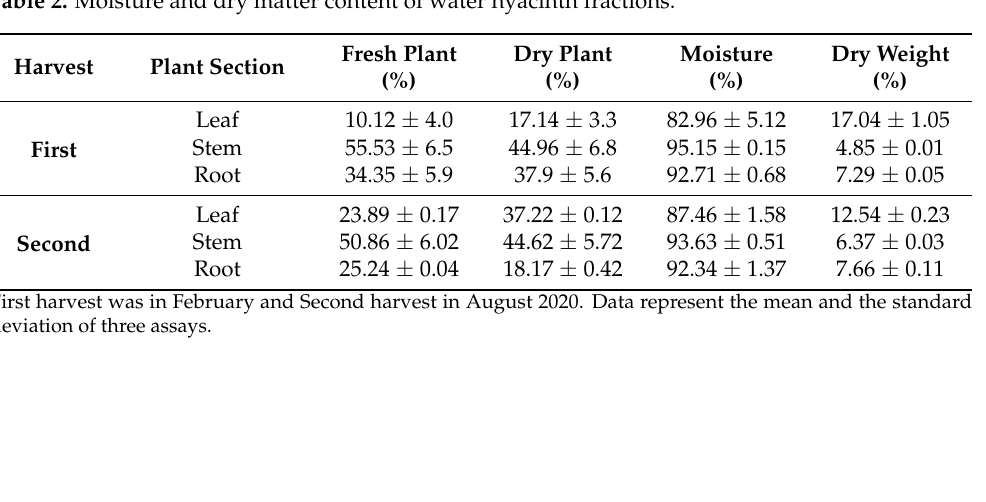
Table 2. Moisture and dry matter content of water hyacinth